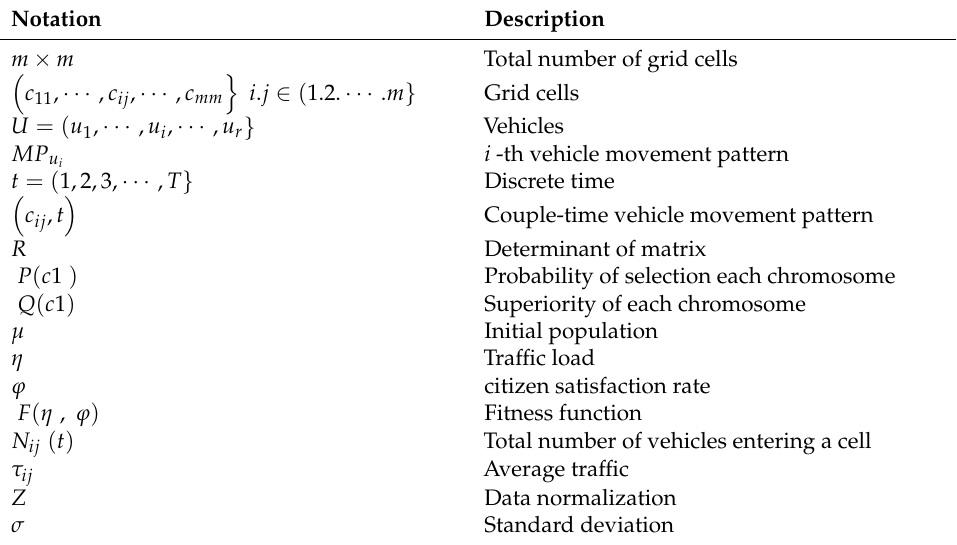
Table 2 contains the notations that used in the system description. Table 2.